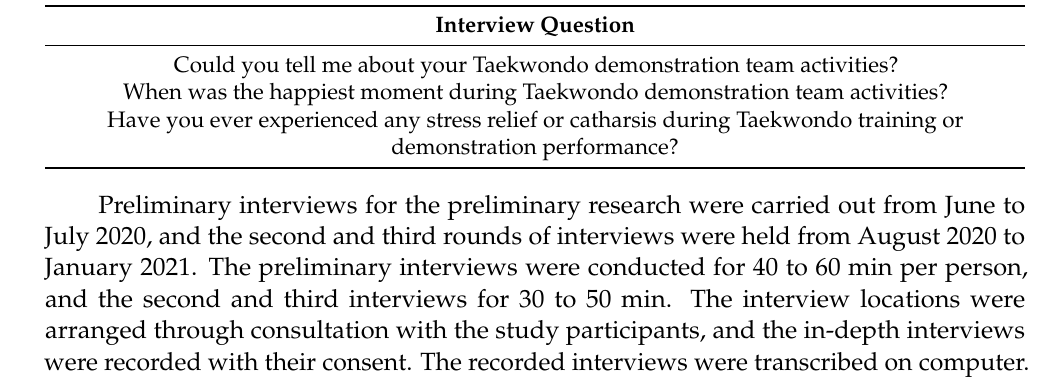
Table 2. Semi-structured interview